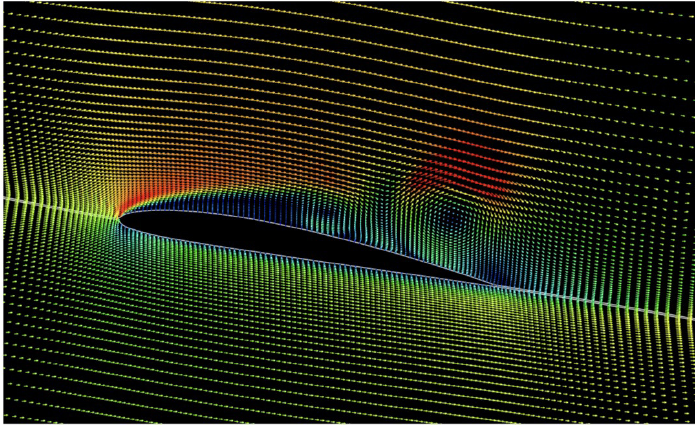
Figure 12. Instantaneous velocity field around NACA2408 airfoil at angle of attack of 8 ◦ and Re = 4000.